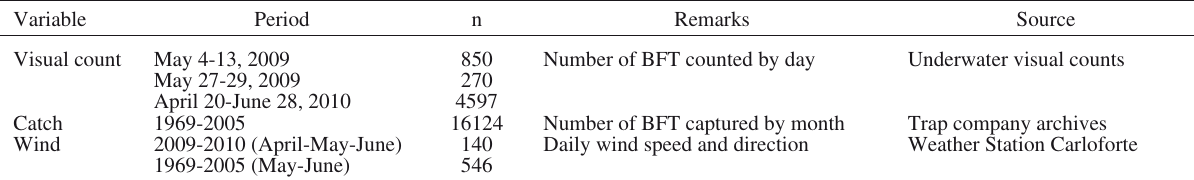
Table 1. – Description of the data sets used in the analysis.